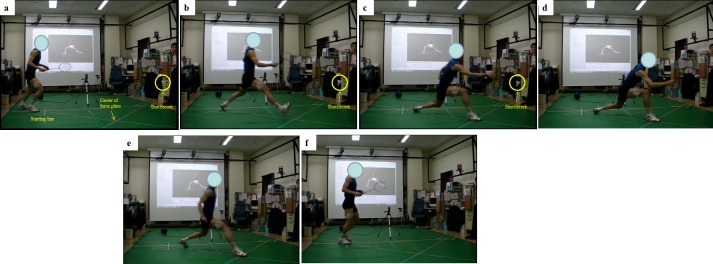
Movement sequence.a) Ready at start line, b) prepare for lunge landing, c) racket hits the shuttle cork, d) complete follow through, e) recovery to the start line and f) finish.